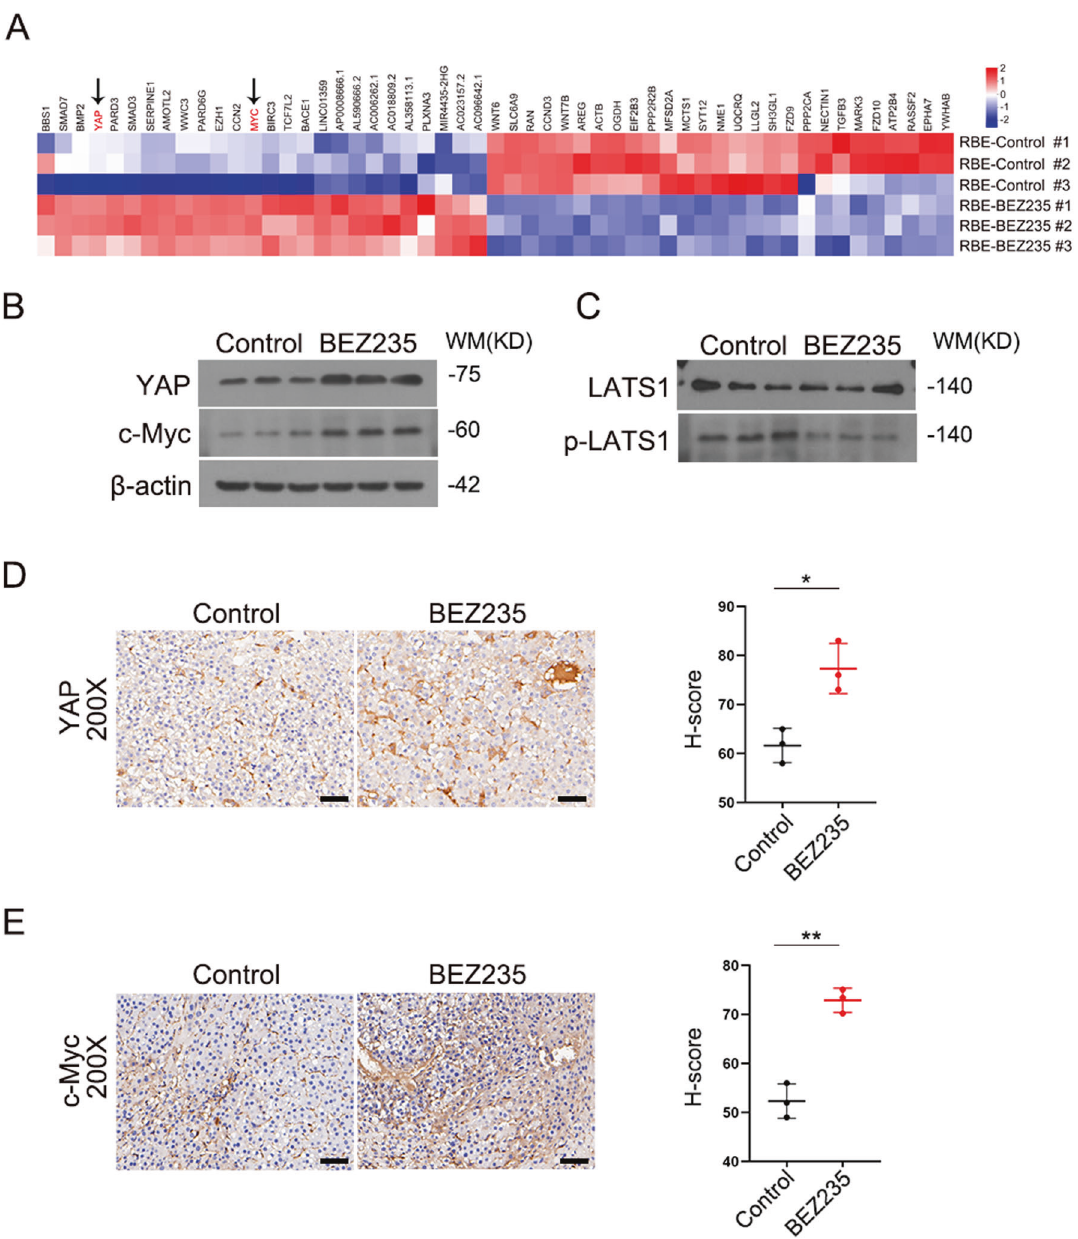
Fig. 3 The PI3K/mTOR dual inhibitor increased c-Myc and YAP expression in vivo and in vitro. A the signi fi cant increase of MYC and YAP expression in BEZ235-treated RBE cells compare to DMSO-treated RBE cells by RNA-seq analysis. B , C The expression of YAP, c-Myc, LATS1 and p- LATS1 was detected in BEZ235-treated RBE cells and DMSO-treated RBE cells by western blotting for screening. D , E Representative immunostaining of YAP and c-Myc in tumor areas in liver sections. Magni fi cation, ×200; scale bar, 50 μ m. The data are shown as the mean ± S.E.M (* p < 0.05, ** p <